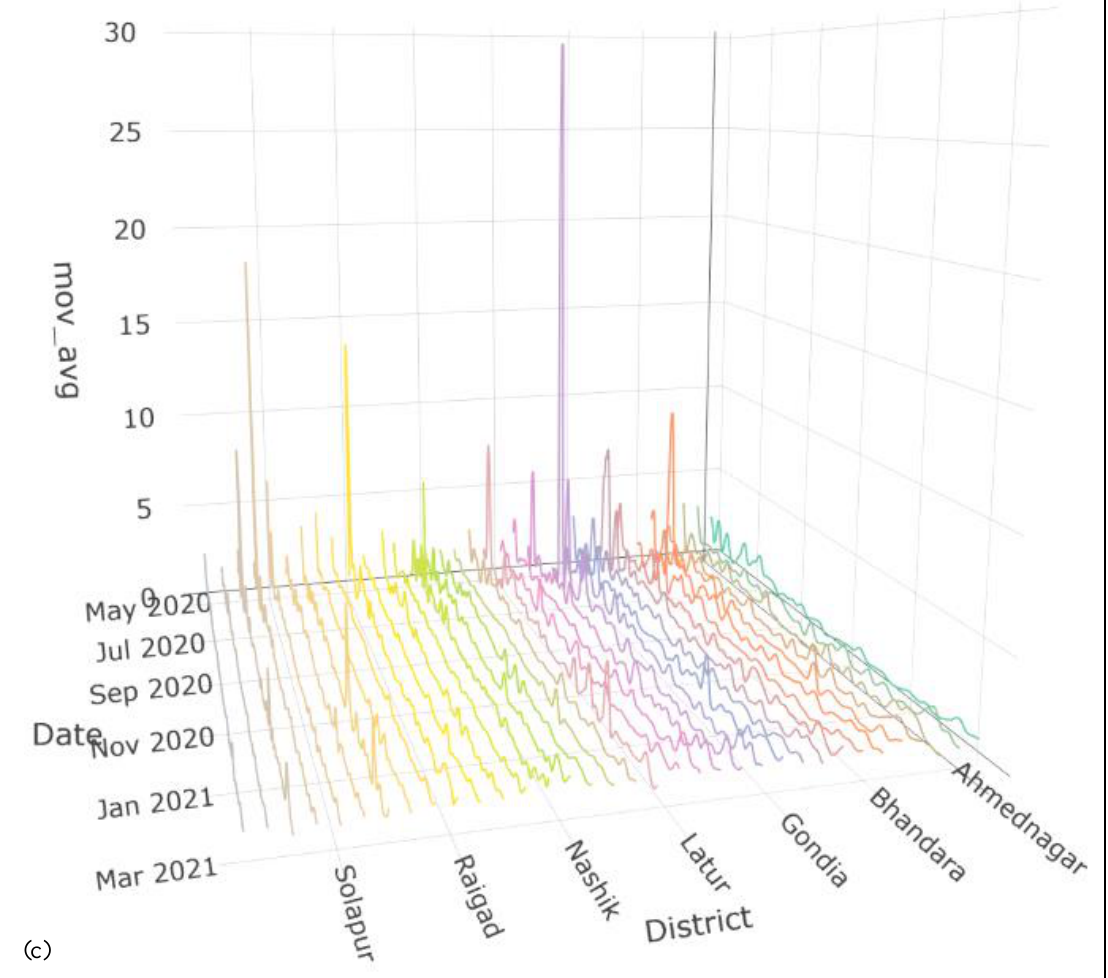
Figure 2. 2D and 3D visualization of the time-dependent reproduction numbers across different states and districts (Maharashtra for the purpose of